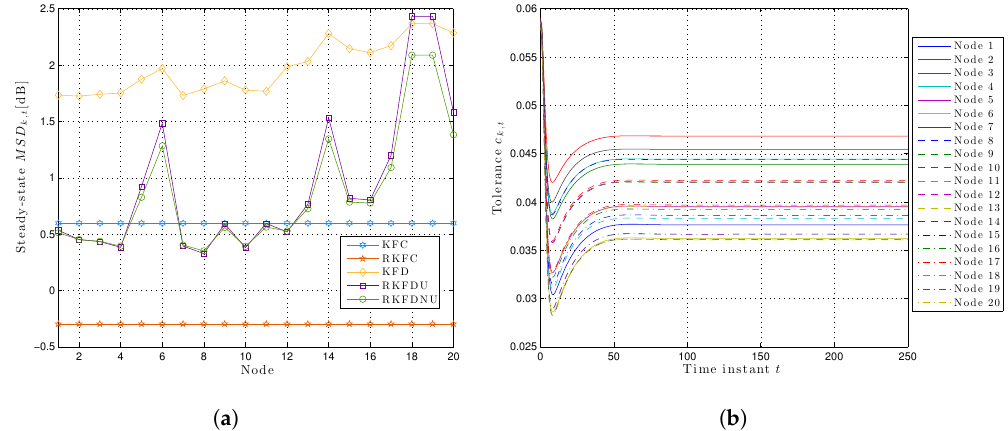
Figure 6. ( a ) Least favorable mean square deviation for each node in the steady-state with tolerance c = 0.06. ( b ) Time-variant local tolerances for each node over time with c = 0.06.